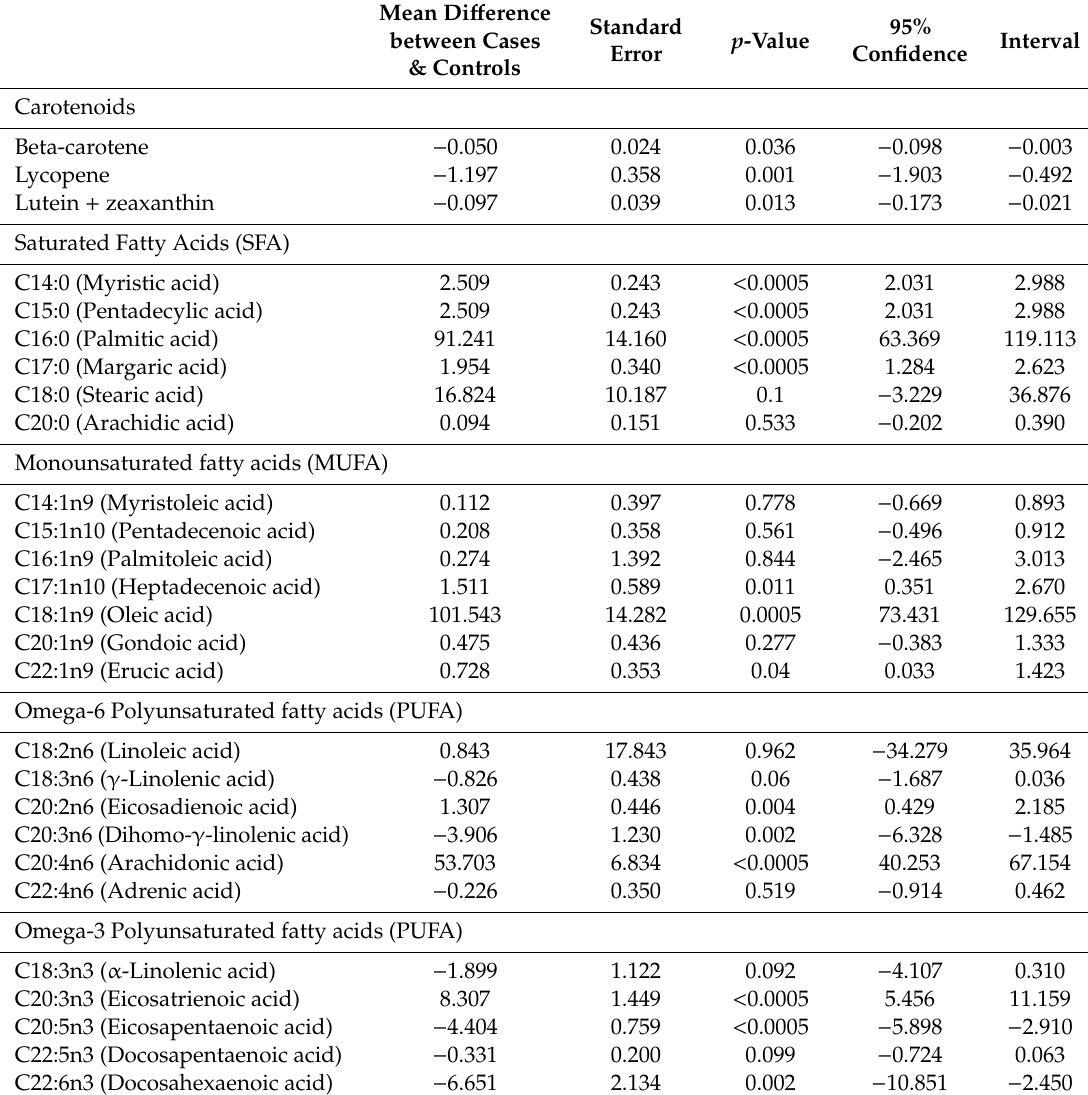
Table 1. Mean di ff erence between the mean values of each tested nutrients between age-related macular degeneration (AMD) cases and